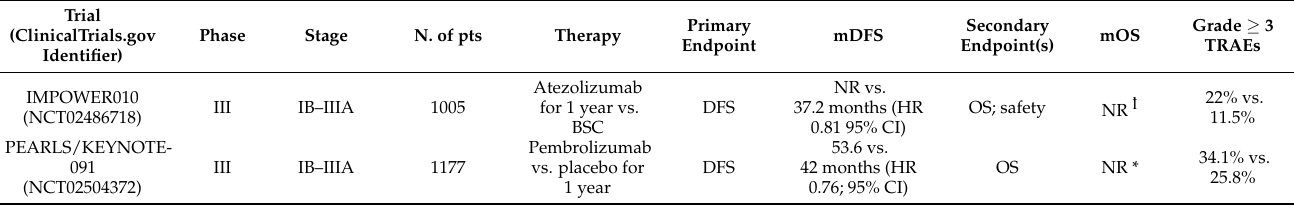
Table 2. Adjuvant immunotherapy in NSCLC.